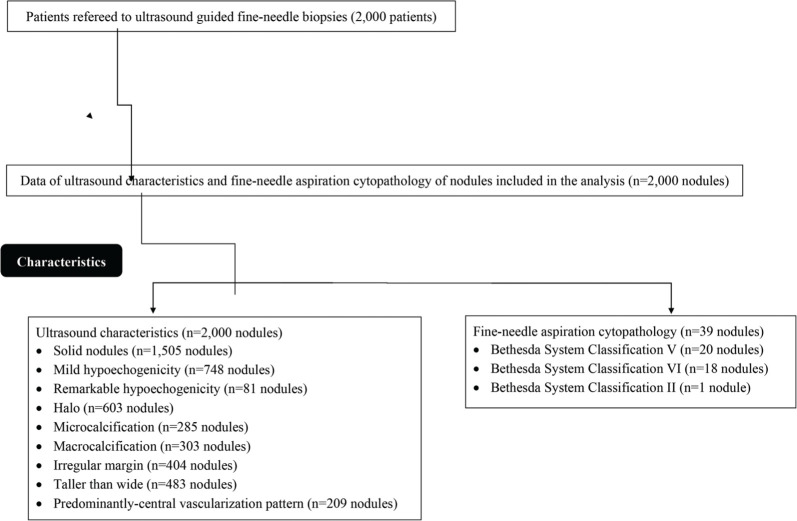
Flow chart of the ultrasound and fine-needle aspiration cytopathology data.